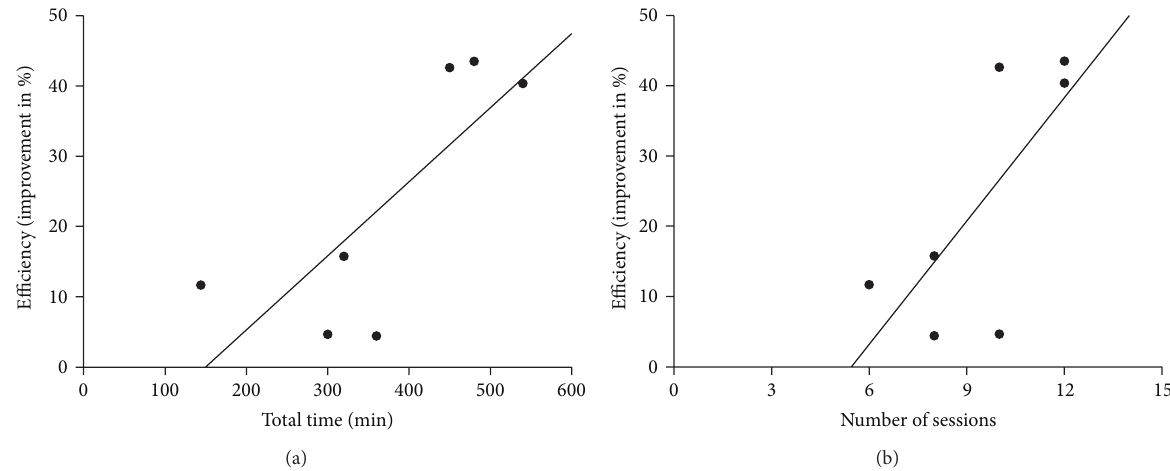
Figure 1: Impact of the duration of virtual reality exposure on treatment efficiency. (a) Average efficiency in terms of symptoms’ improvement as a function of the total time spent in virtual reality-based therapy (linear regression, 𝑟 2 = 0.5975 , 𝑃 < 0.05 ). (b) Average efficiency in terms of symptoms’ improvement as a function of the total number of sessions of virtual reality-based treatment ( 𝑟 2 = 0.5164 , 𝑃 = 0.07 ).